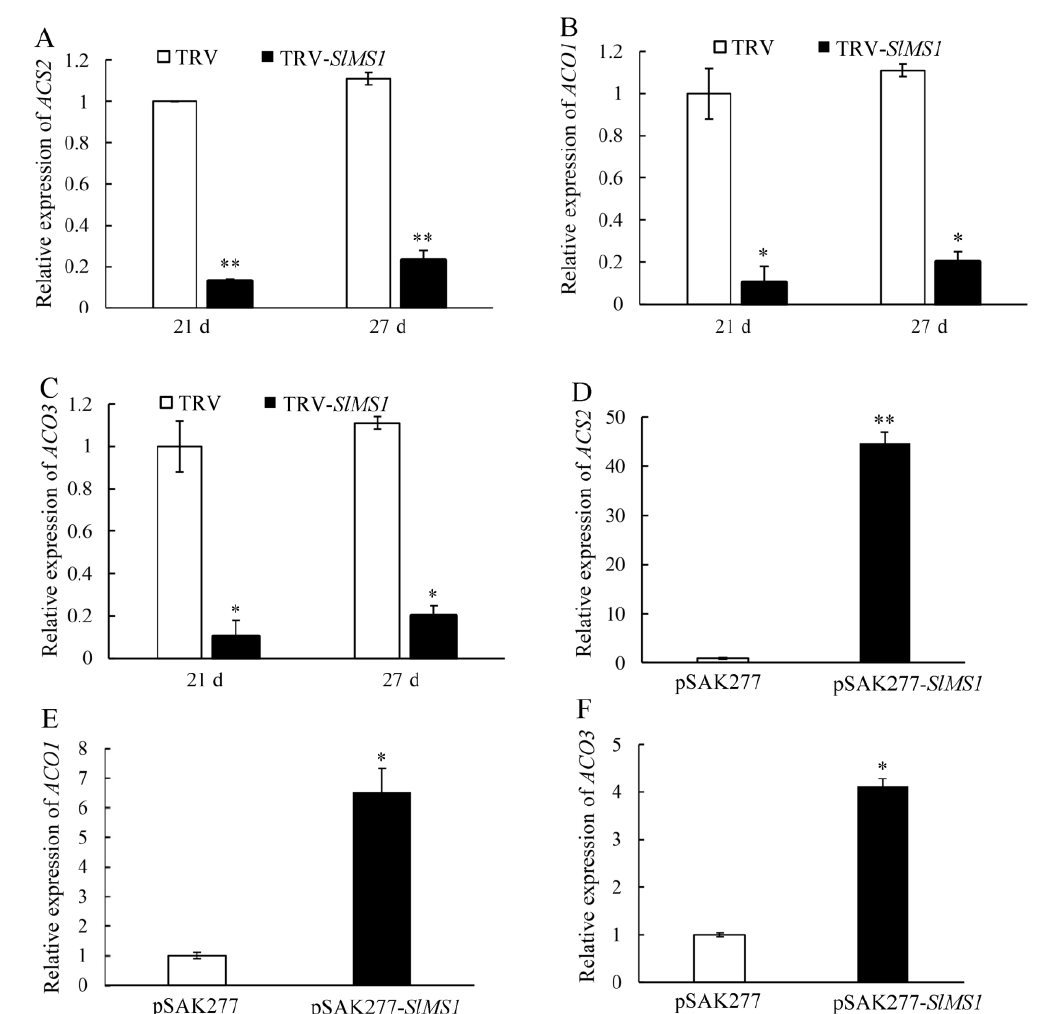
Figure 7. Effect of transient silencing and transient overexpression of SlMS1 on gene expression of ethylene biosynthesis related genes ACS2, ACO1 and ACO3 in tomato fruit. ( A – C ) Relative gene expression of ACS2 ( A ), ACO1 ( B ) and ACO3 ( C ) in control (TRV) and SlMS1 -silenced fruit (TRV- SlMS1 ) at 21 and 27 days post inoculation. ( D – F ) Relative gene expression of ACS2 ( D ), ACO1 ( E ) and ACO3 ( F ) in control (pSAK277) and SlMS1 -overexpressed (pSAK277- SlMS1 ) fruit at 10 days post inoculation. The symbols * and ** stand for p < 0.05 and p < 0.01, as determined by Student’s t -test, respectively.